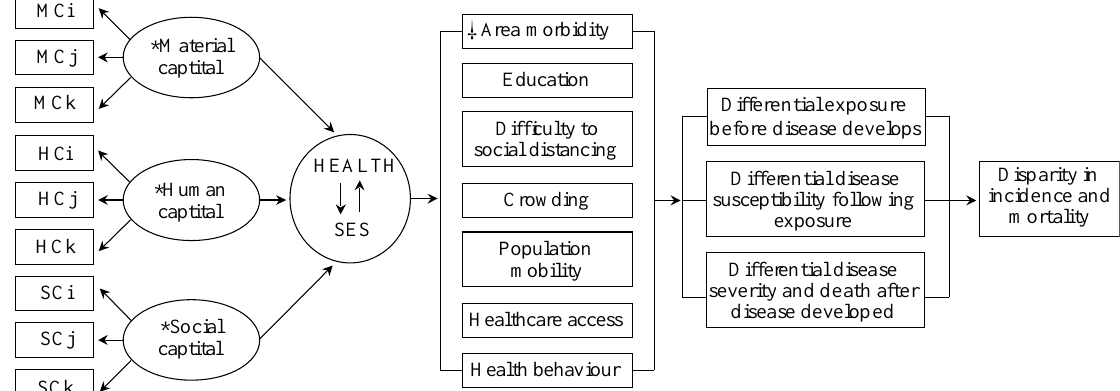
Figure 1. Conceptual model of the causal relationship between the SARS-CoV-2 and area health/SE determinants. Abbre- viations: material capital (MC), human capital (HC), social capital (SC), socioeconomic status (SES). Subscripts (i, j, k) indicate the number of variables used from the data sources. *Material, Human and Social Capital refers to latent structural components of the SES and COVID-19-specific determinants. Health and SES connected by arrows indicate the inter-re- latedness of area health and SES, hereinafter, denoted as a health/SE. ⸸ Area-health/SE themes identified relevant to COVID-19 based on the current person and population-level literature. As per Coleman’s social theory and contributing data underlying each health/SE theme, crowding, healthcare access and social distancing relates to material capital, health behaviour and area morbidity relates to human capital, whereas, crowding, education and population mobility to social capital. Modified from source [9,24]. Data sources: Korean Community Health Survey by the KCDC, Health Insurance Statistics by the National Health Insurance Services, Disability Status by the Ministry of Health and Welfare, Death Cause Statistics by the National Statistics Agency, Korean Census Bureau, Internal Migration Statistics by the Statistics Korea, and the State of Urban Planning Report by the Ministry of Land, Infrastructure, Transport, and Tourism.